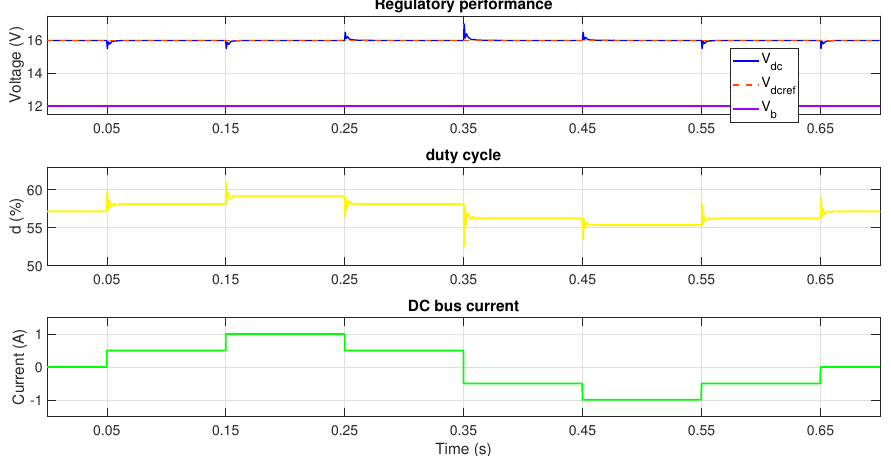
= 16 V (boost mode). ref